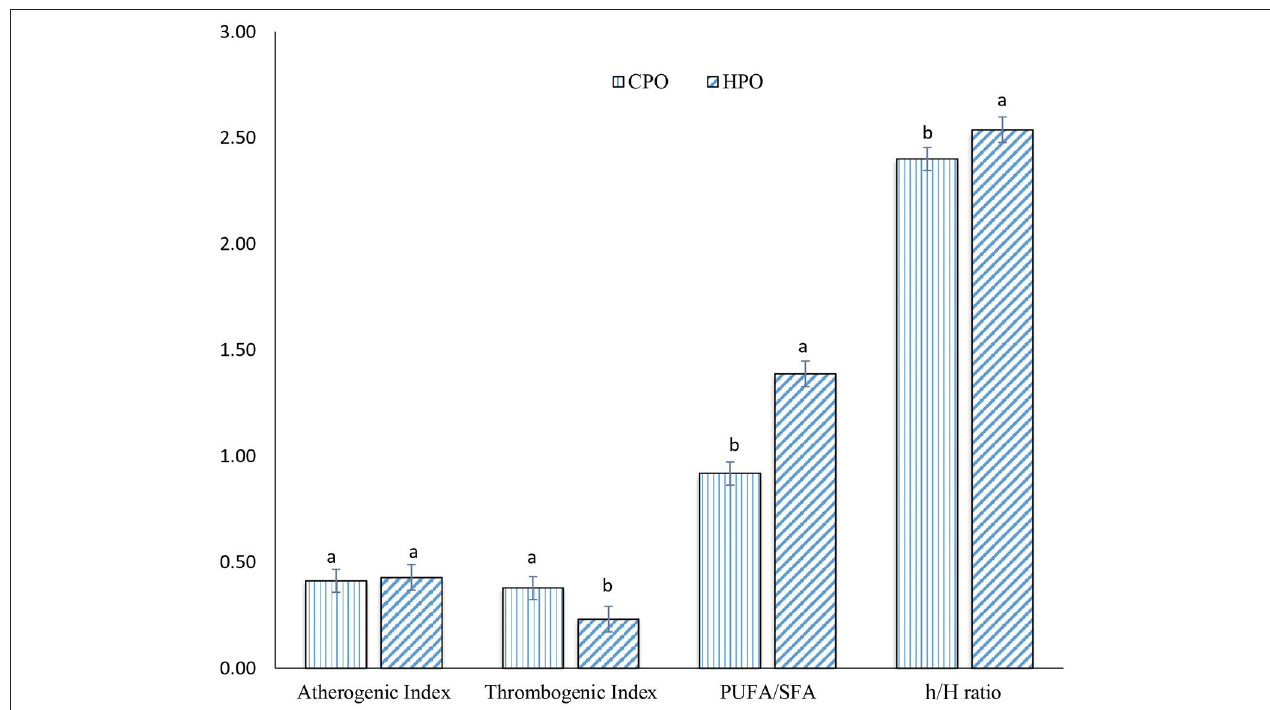
FIGURE 2 | Nutrition indices of CPO and HPO. CPO: Oil extracted from cephalothorax; HPO: oil extracted from hepatopancreas. Different lowercase letters within the same nutrition index denote significant difference ( p < 0.05).